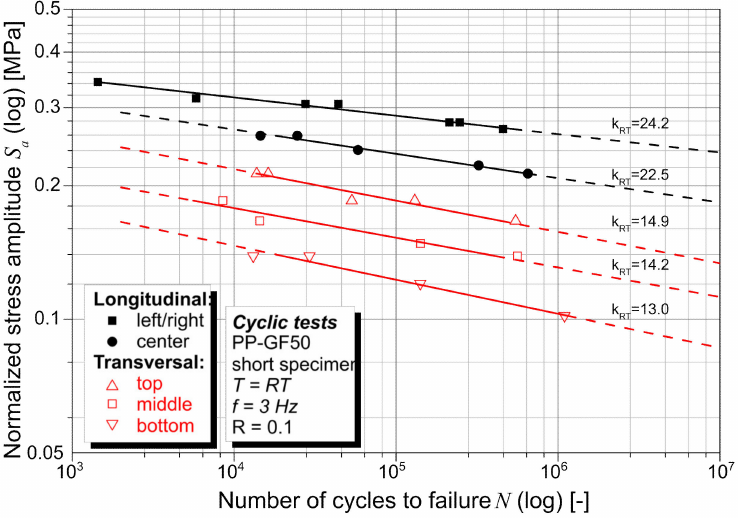
Figure 5. S/N-curves for quasi-static test results at all investigated